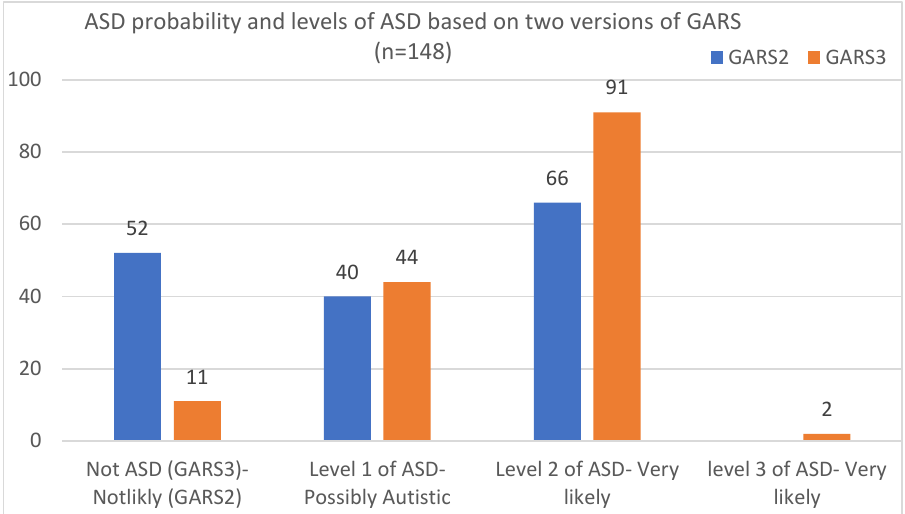
Figure 3. Comparisons of the number of children in each level of diagnosis of ASD (based on the 3rd version) and the probability of ASD (based on 2nd version of the scale).